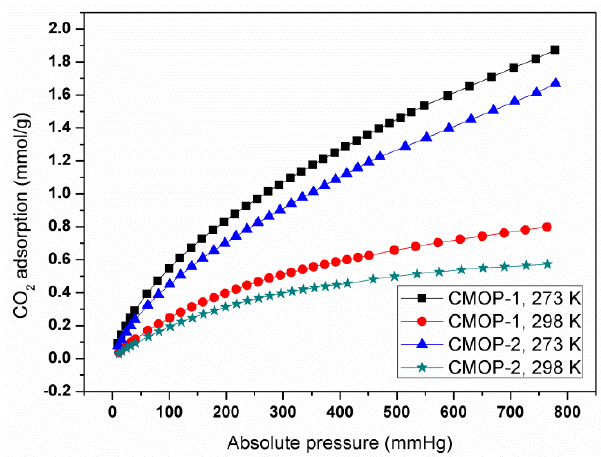
Figure 2. CO 2 adsorption isotherm at 273/298 K.